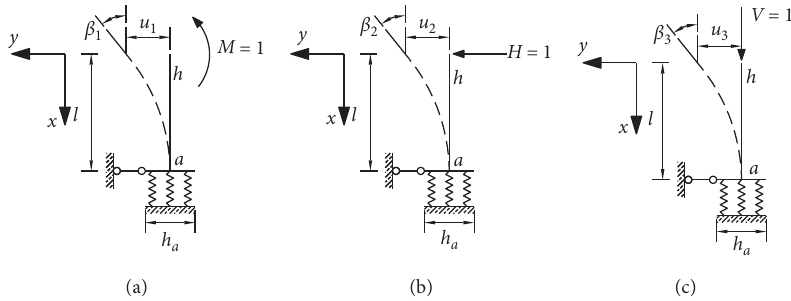
Figure 27: The displacements of the side wall under unit load: (a) M � 1; (b) H � 1; (c) V � 1.